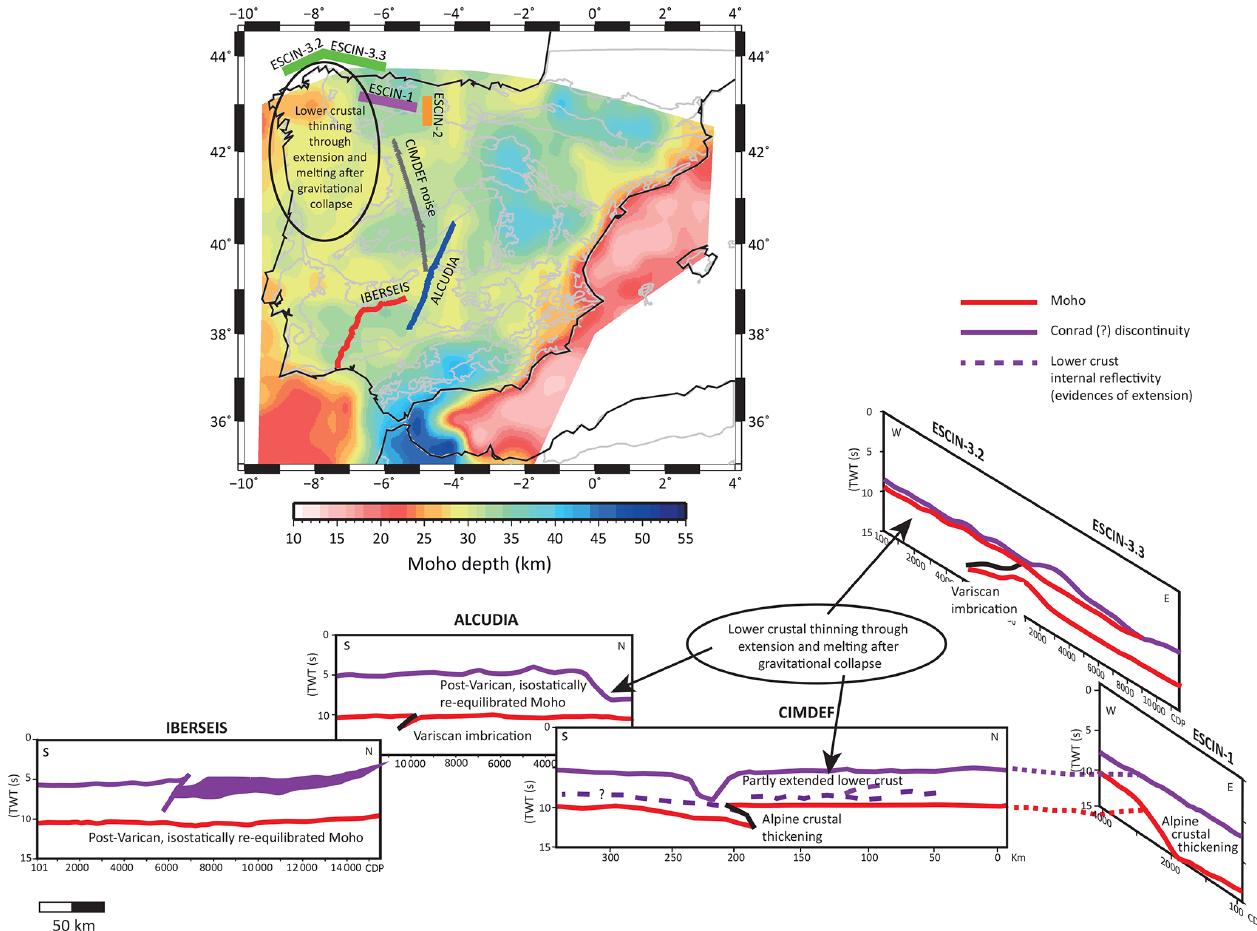
Figure 10. Map of the Moho depth as derived from tomography of shear waves (seismic noise and earthquakes; Palomeras et al., 2017) with the projection of the seismic profiles already shown in Fig. 1 and described in the text. A sketch of the geometry of the main discontinuities (Moho and Conrad) is also